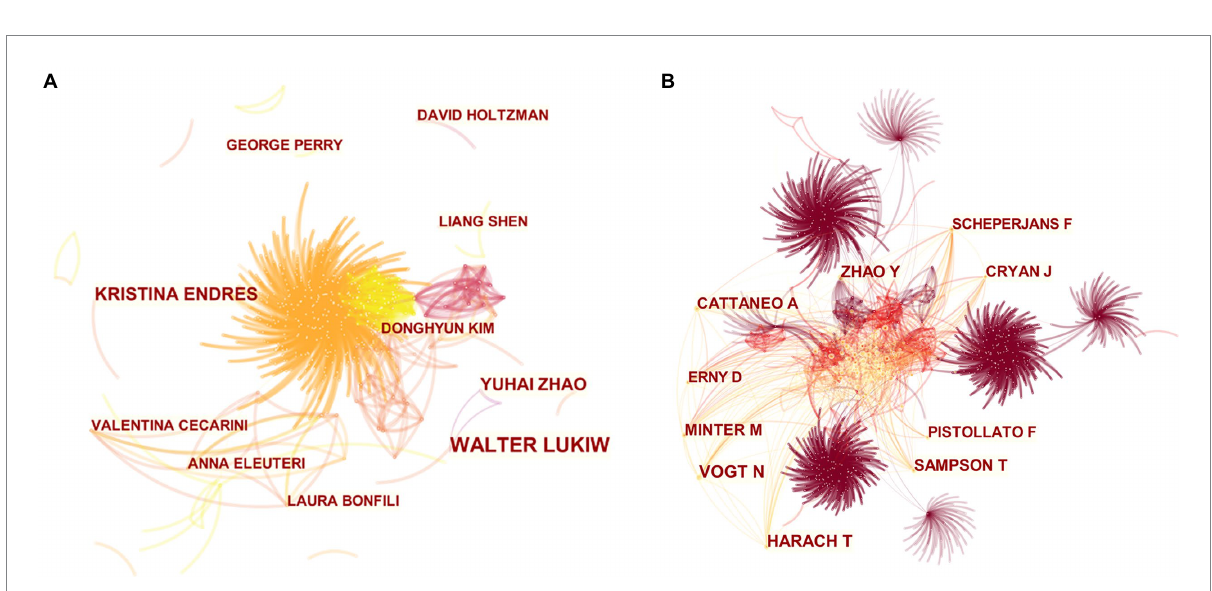
FIGURE 5 Collaboration and co-cited networks of authors. (A) Network of author interaction. (B) Network of author co-citation. The size of the nodes in the graph represents the number of publications of the institution, and the thickness of the lines between nodes represents the strength of the relationship. The different colors of nodes and connection lines represent different years (for instance, fuchsia represents 2013–2014, orange red represents 2017–2018, and yellow represents 2021 in panel A ; fuchsia represents 2013–2014, orange represents 2017–2018 in panel B ).